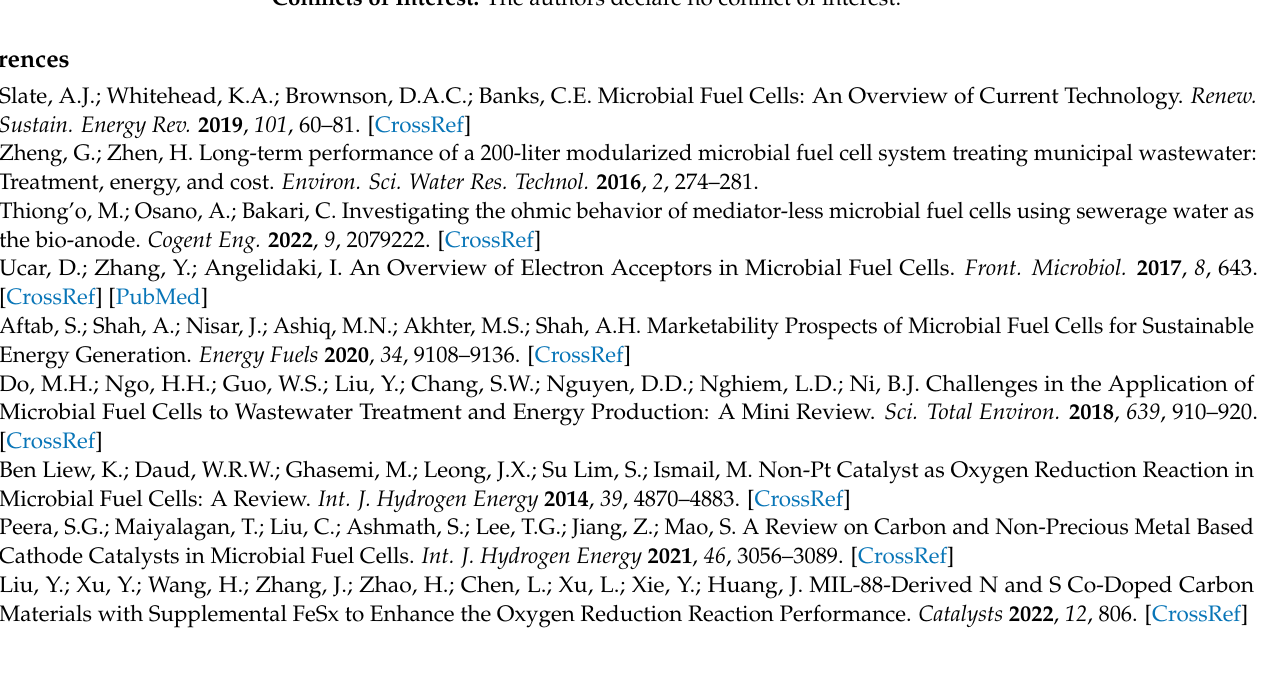
resolution scan. Figure S2.T: Elemental composition of Co-NSC-3 catalyst obtained from XPS analysis; Figure S3. TEM images of Co/NSC-3 catalysts after stability